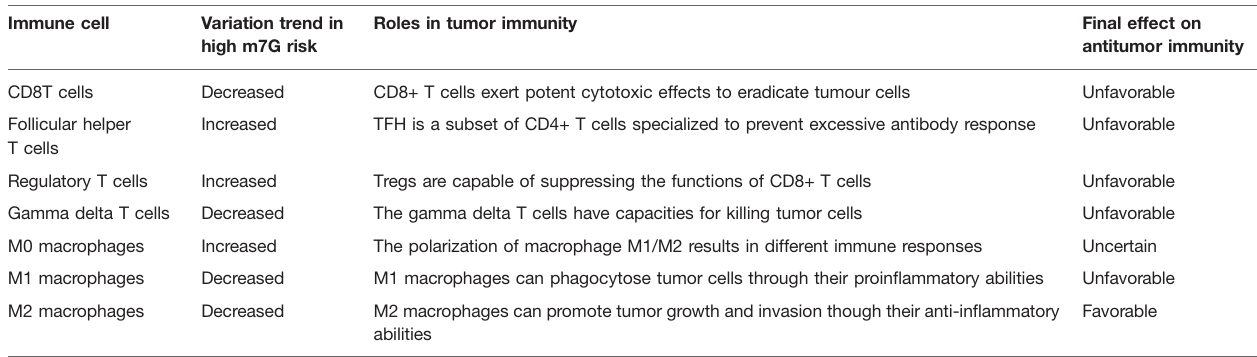
TABLE 1 | Effects of m7G risk levels on tumor immune microenvironment.